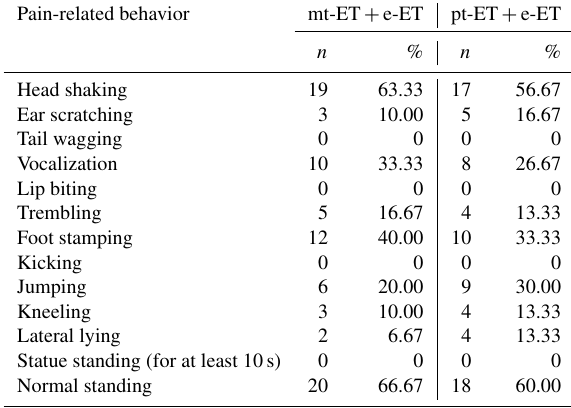
Table 3. Behavioral criteria used to assess pain in lambs with metal- tipped + electronic and plastic-tipped + electronic ear